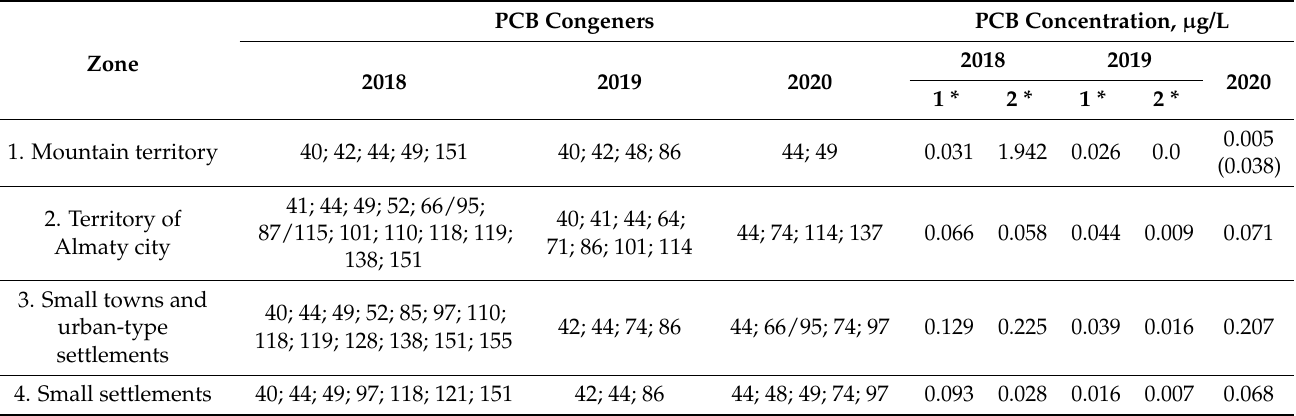
Table 3. Average content and congener composition of PCBs in snow cover of the Almaty